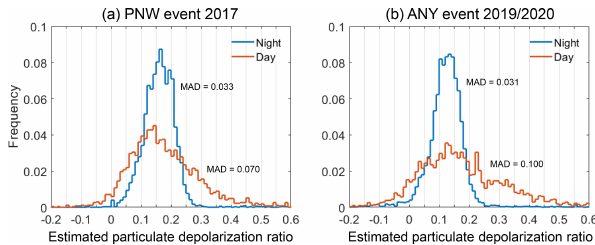
Figure 21. Nighttime- and daytime-estimated particulate depolar- ization ratio distributions for all stratospheric aerosol layers de- tected during the first 2 weeks after (a) the PNW event (Northern Hemisphere) and (b) the ANY event (Southern Hemisphere). Low- γ (cid:48) , PSA, and layers with | CAD score | < 20 are